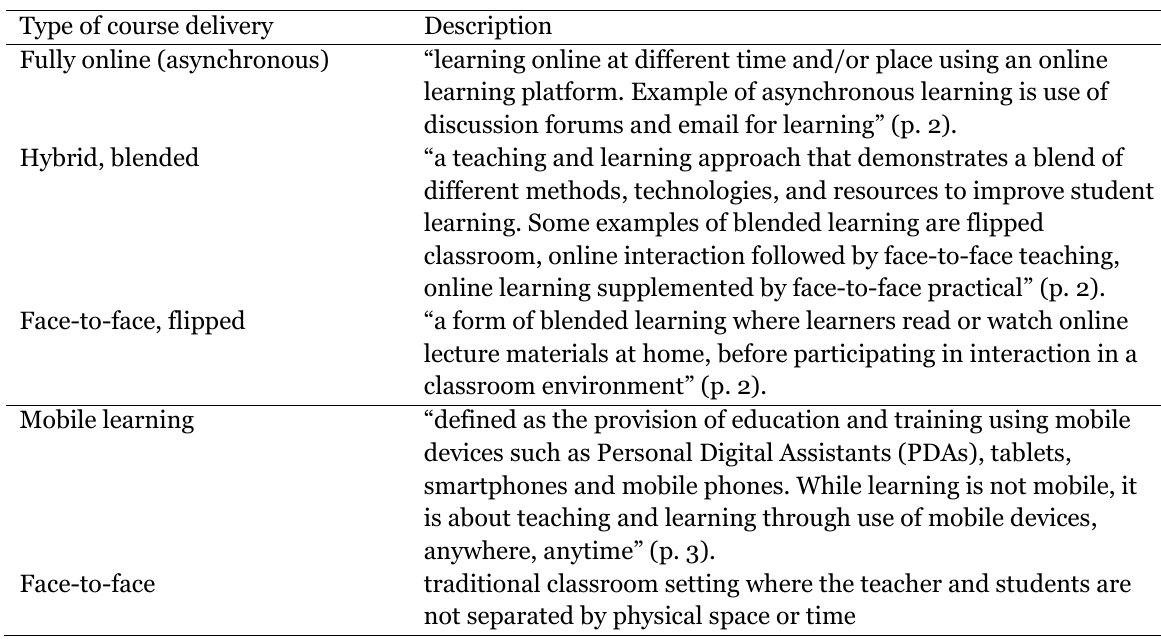
Descriptions of Distance Learning Delivery